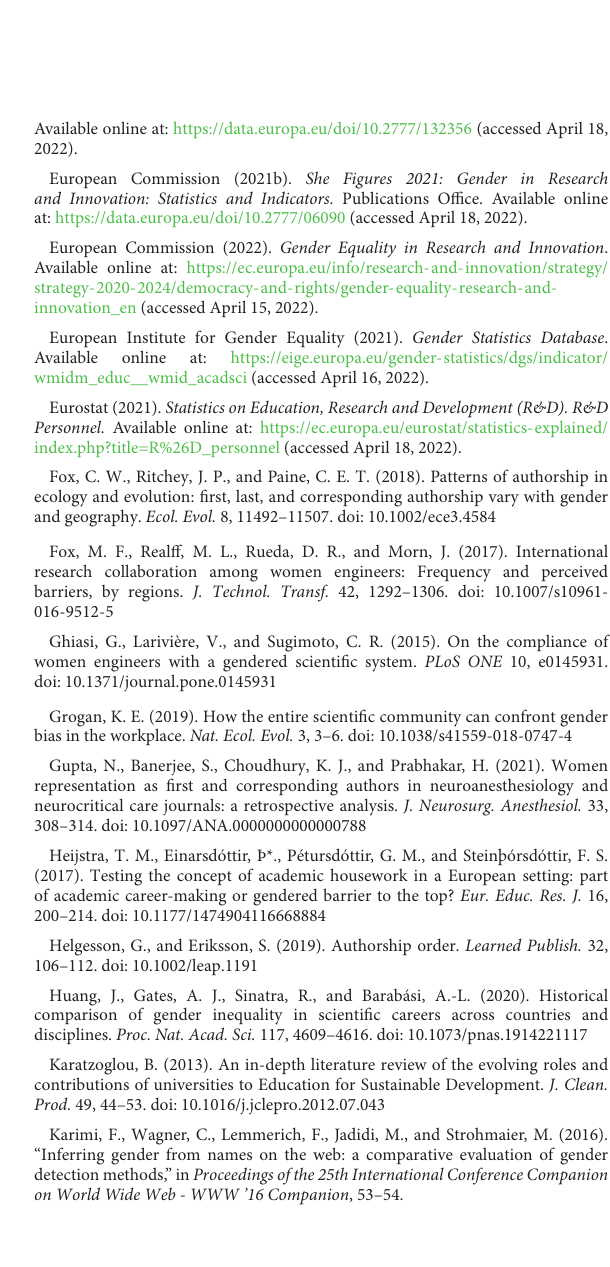
SUPPLEMENTARYFIGURES1 Collaboration maps by papers authored only by men. SUPPLEMENTARYFIGURES2 Collaboration maps for mixed-gender